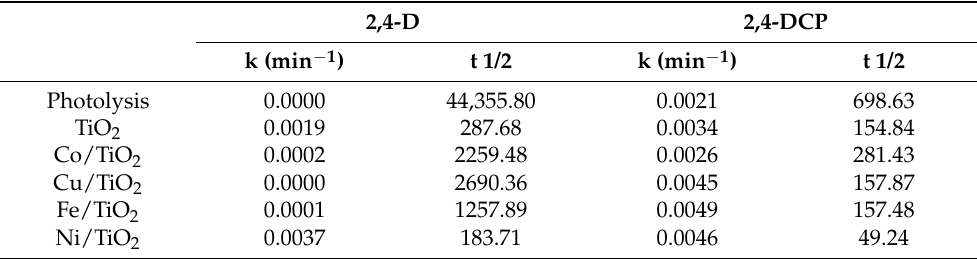
Table 3. Rate constant for the pseudo-first order kinetic equation and half-life time for the 2,4-D and 2,4-DCP degradation in the presence of TiO 2 pure and deposited-TiO 2 catalysts. 2,4-D